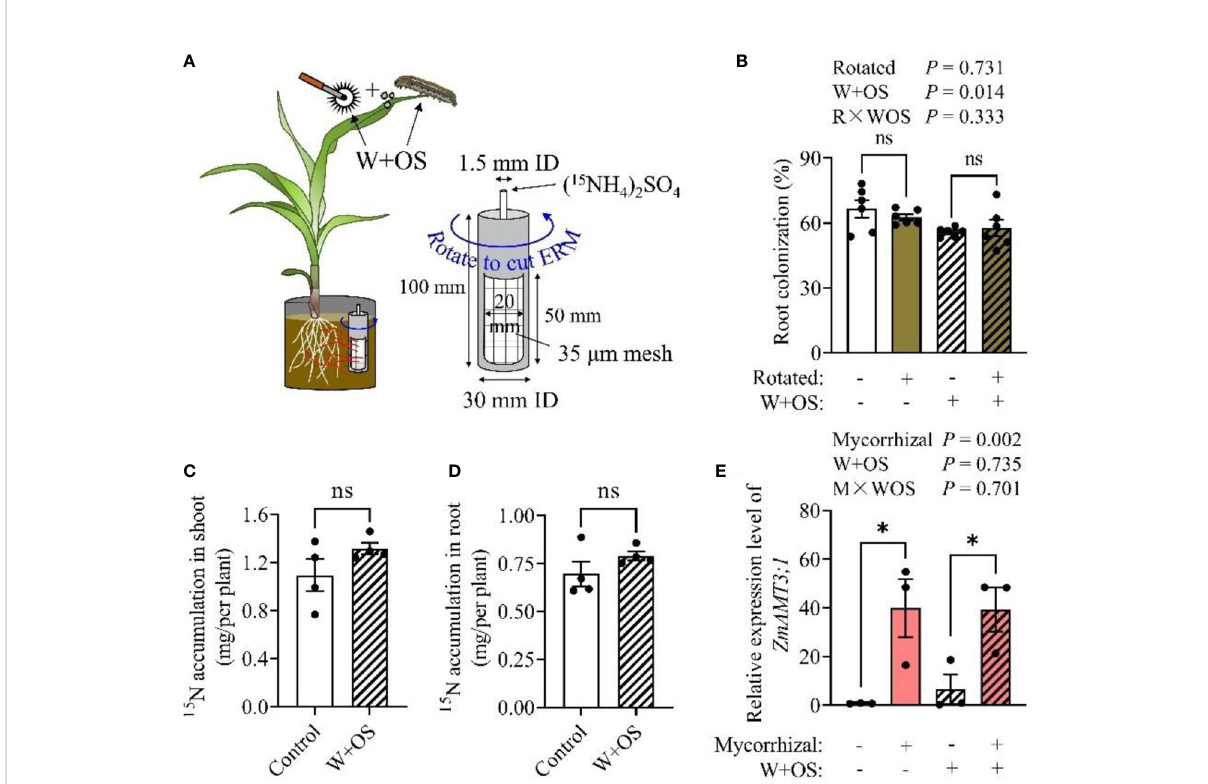
FIGURE 3 Mycorrhiza-mediated nitrogen uptake from soil by maize plants is independent of aboveground herbivory. Maize plants were inoculated with Rir and were cultivated in self-designed boxes, with a PVC core in each box as illustrated in experiment III. Five weeks post Rir inoculation, the PVC core was injected with ( 15 NH 4 ) 2 SO 4 solution, and was then either rotated daily (for the purpose of severing the mycelium) or nontreated (Intact) for 10 days, during which W+OS treatment was introduced (A) . Plants were then harvested to measure the root colonization rate (B) , shoot 15 N (C) , root 15 N (D) , and ZmAMT3;1 (a mycorrhizal inducible nitrogen transporter gene) expression (E) . The 15 N in Intact- ’ W+OS ’ minus the 15 N in Rotated- ’ W+OS ’ (to counteract the effect of root acquisition of 15 N) was present as a ‘ Control ’ , and 15 N in Intact+ ’ W+OS ’ minus the 15 N in Rotated+ ’ W+OS ’ (to counteract the effect of herbivory on root acquisition of 15 N) was present as ‘ W+OS ’ in (C) and (D) . NM, non-mycorrhizal roots; AM, arbuscular mycorrhizal roots. For the analysis of root colonization, n = 6; 15 N accumulation, n = 4; ZmAMT3;1 expression, n = 3. Data are the means ± SE of biological replicates. Asterisks indicate signi fi cant differences (Student ’ s t-test, * P < 0.05; ns, no signi fi